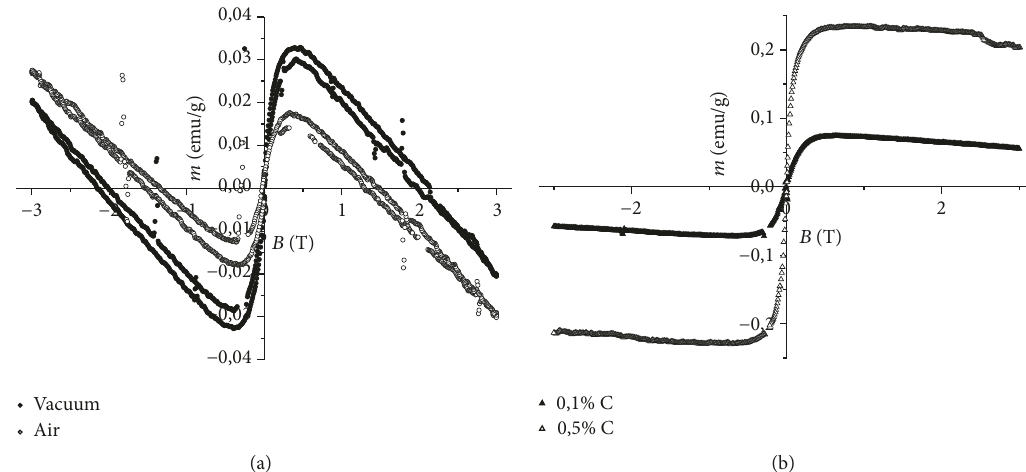
Figure 4: Dependence ofspecific magnetization on induction of a magnetic field, (a) thenondoped NP ZnO, produced in different conditions (in vacuum (number 1) and in the air atmosphere (number 2)) and then annealed in air at 773 K, and (b) the carbon-doped NP ZnO with various concentrations of carbon: sample number 3, 0.1wt% C, and sample number 4, 0.5 wt% C.